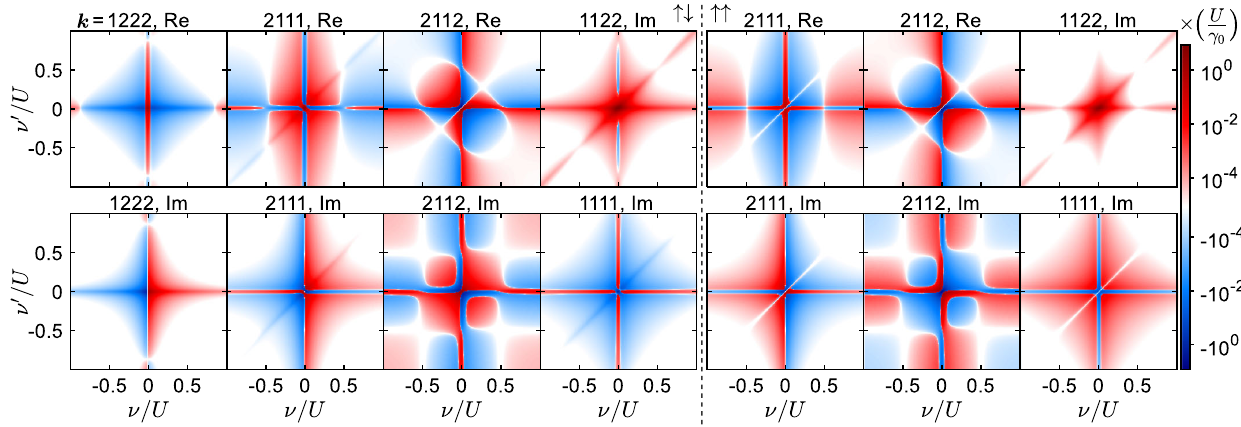
− F k =U of the HA at ω ¼ 0 and T=U ¼ 1 = 50 (using γ 0 ¼ T ). The left-hand (right-hand) panels show FIG. 11. KF 4p vertex ð F k σσ 0; σσ 0 Þ 0 σ ≠ σ 0 ( σ ¼ σ 0 ), the top (bottom) rows the real (imaginary) part, except for the purely imaginary k ¼ 1122 and 1111 components. Keldysh components not plotted look similar to those that are plotted: components where k has only one 1 are analogous to 1222 (these vanish for σ ¼ σ 0 ); those with only one 2 are analogous to 2111; 1122 corresponds to 2211, while other components with two 1 ’ s and two 2 ’ s are similar to 2112. The 2222 vertex vanishes identically.